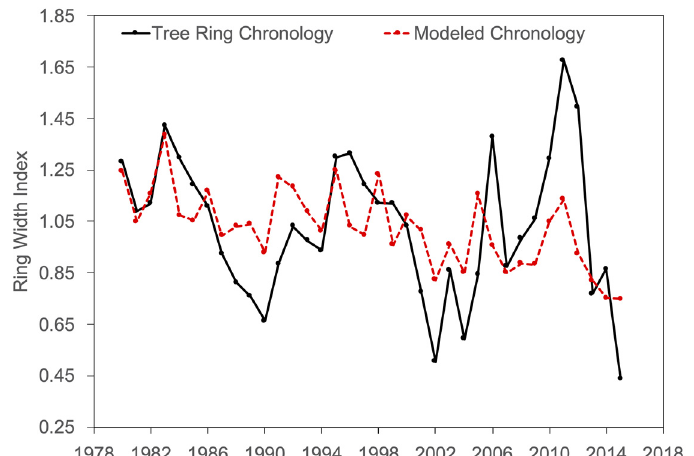
Figure 6. The Crestline Chronology plotted against a model of tree growth using only March PDSI and pOct–Sep NO 2 based on the stepwise regression model. The correlation (r 2 ) is 0.671, the adjusted r 2 is 0.651, F = 33.66, and the standard error is